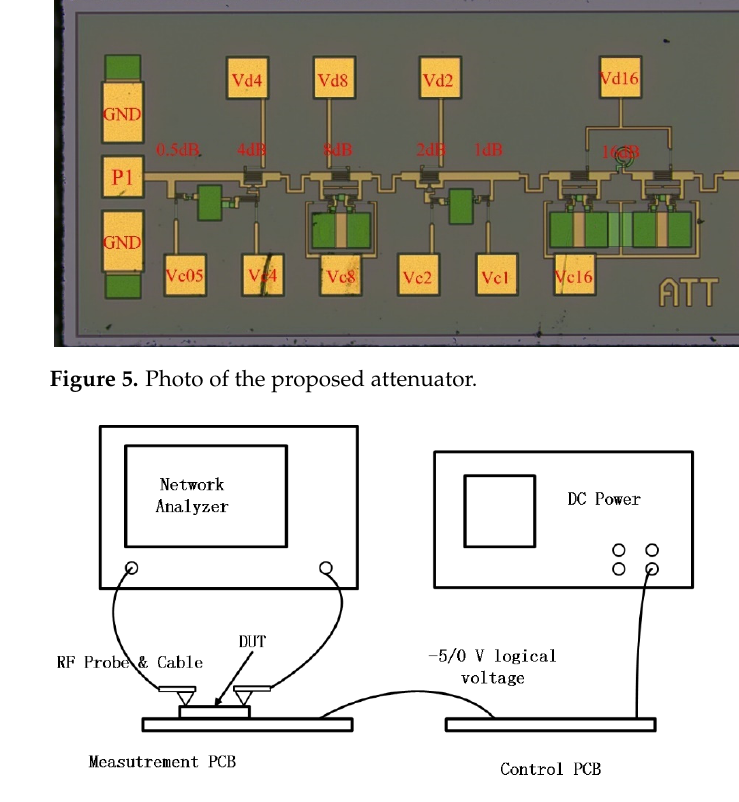
-15 Figure 7. Measurement results of the S21 in all states. ( a ) ( b ) Figure 8. ( a ) Measurement results of the S21 in the main states. ( b ) The relative phase difference curve of the main states. ( a ) ( b ) Figure 9. ( a ) Measurement results of the S11 and ( b ) S22. 0 2 4 6 8 10 12 14 16 18 20-40-35-30 -25-20